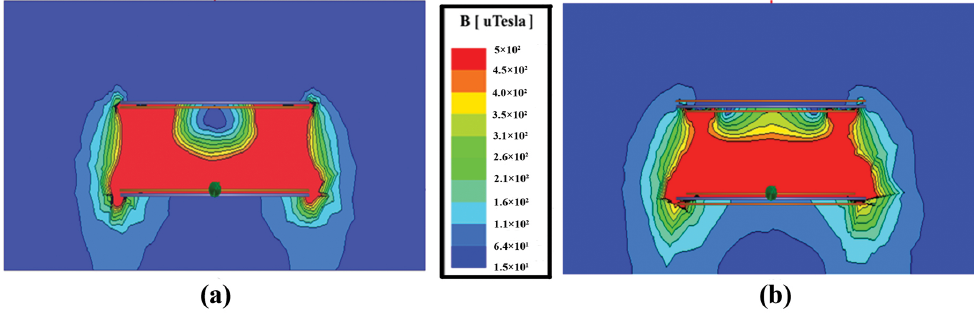
Figure 19. Magnetic flux distributions for side plane ( µ T); ( a ) case 1 and ( b ) case 2.